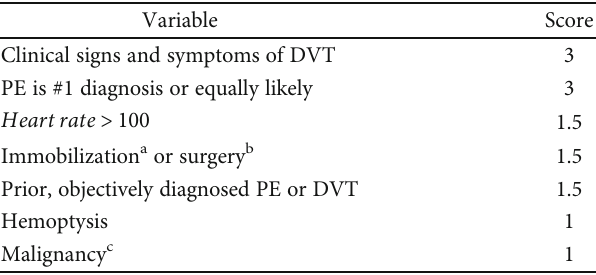
Table 1: Wells criteria.